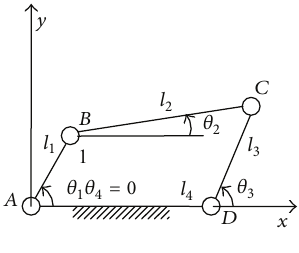
Figure 2: Four-bar mechanism.